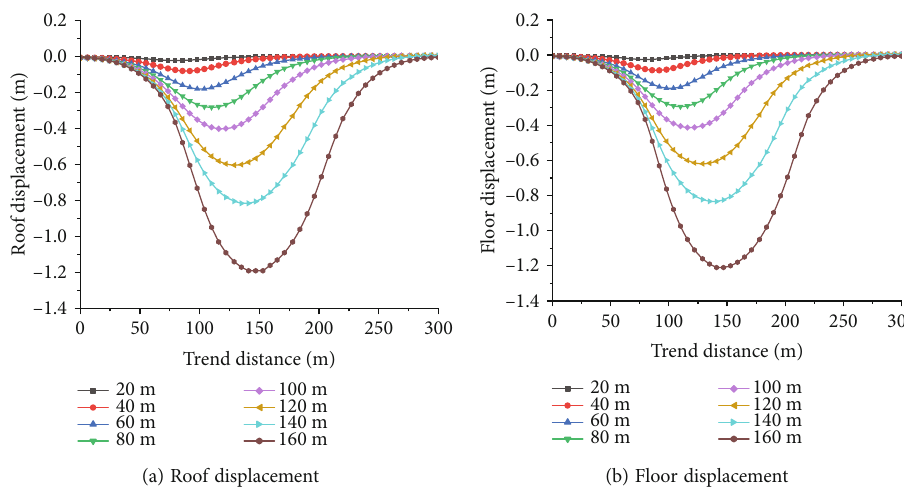
Figure 8: Displacement curves of C